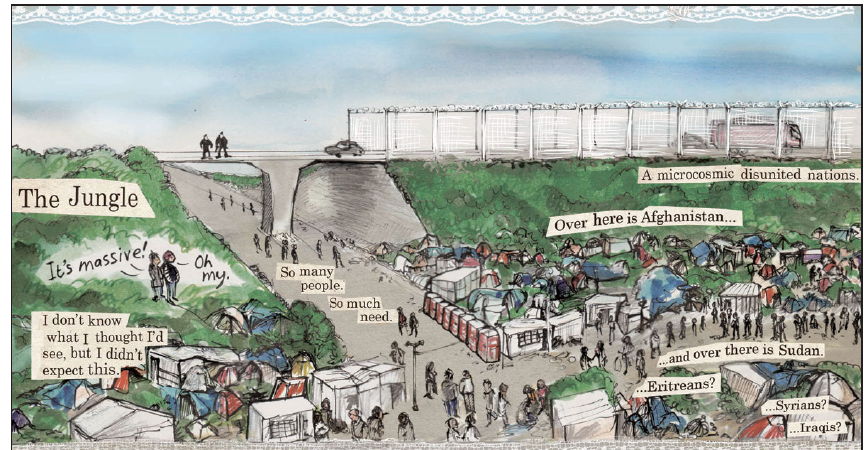
Figure 1: Excerpt from Evans, Kate (2017) Threads: From the Refugee Crisis (London & New York: Verso) © Kate